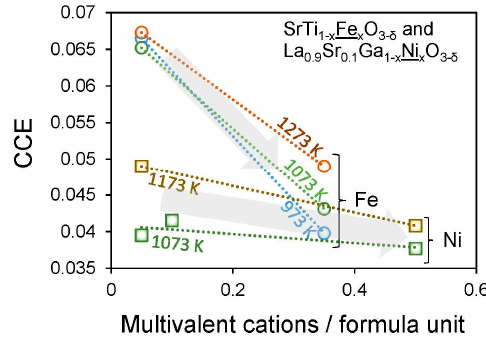
Figure 6. Coefficients of chemical expansion, CCEs, as a function of multivalent cation concentration per formula unit, i.e., x in SrTi 1 − x Fe x O 3 −δ and in La 0.9 Sr 0.1 Ga 1 − x Ni x O 3 −δ demonstrating correlation